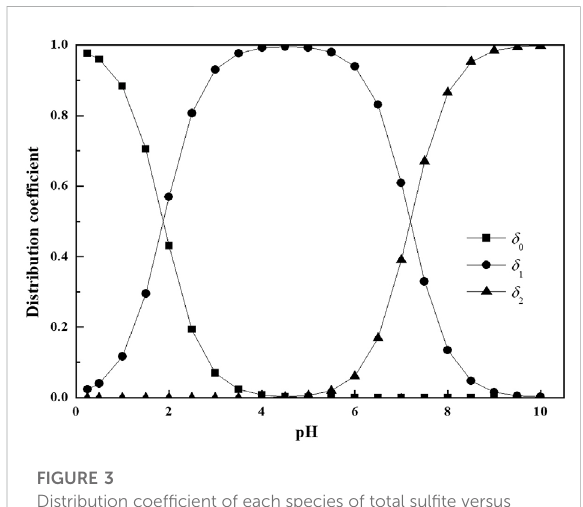
FIGURE 3 Distribution coef fi cient of each species of total sul fi te versus pH ( T =